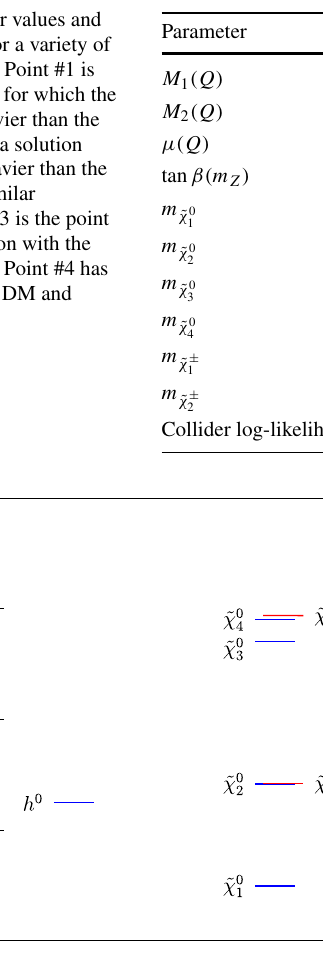
Fig. 10 The electroweakino mass spectra [154] for our best-fit point (benchmark point #1; left) and another point with a similar likelihood but with heavier winos (benchmark point #2; right). The benchmarks are defined in Table 7